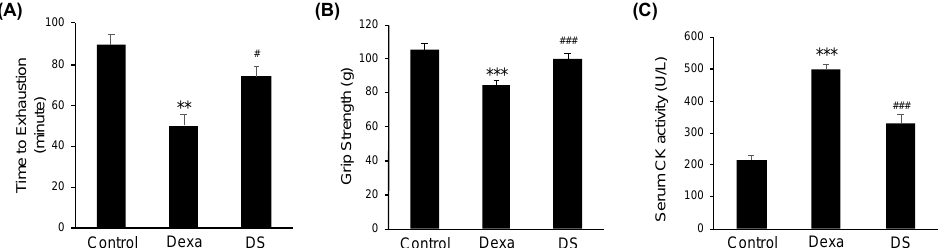
Figure 2. β -sitosterol ameliorates Dexa-induced muscle dysfunction in mice. ( A ) Forced running time. ( B ) Grip strength. ( C ) Serum CK activity. ** p < 0.01 and *** p < 0.001 compared to the untreated control. # p < 0.05, ### p < 0.001 compared to the to the Dexa treated control. DS—dexa + β -sitosterol; CK—creatine kinase.